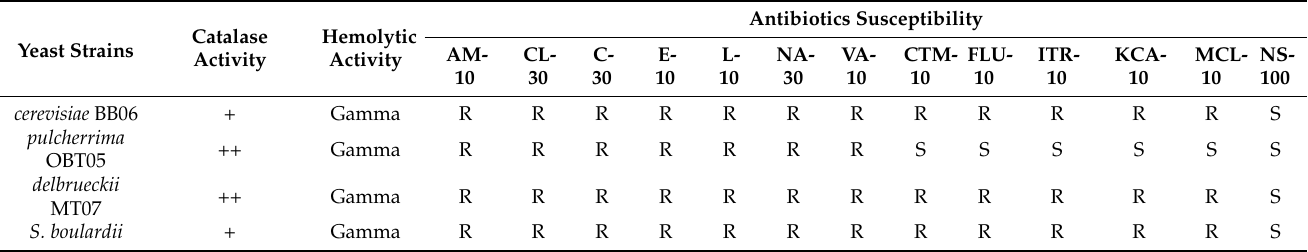
Table 2. Safety issues assessment of yeast strains.